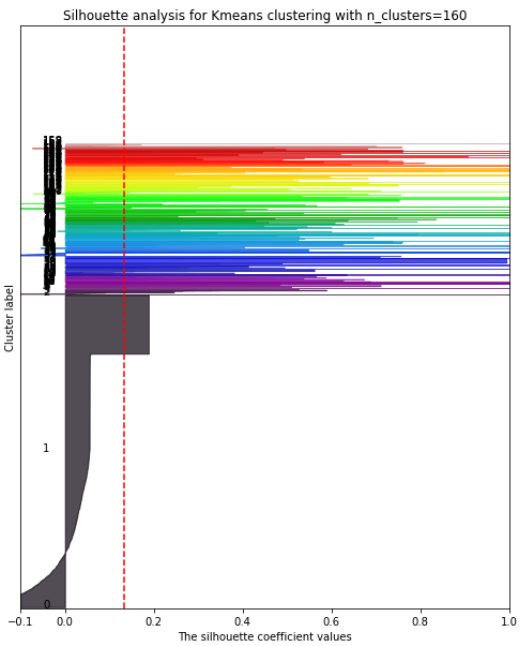
Fig 4. Silhouette plot for 160